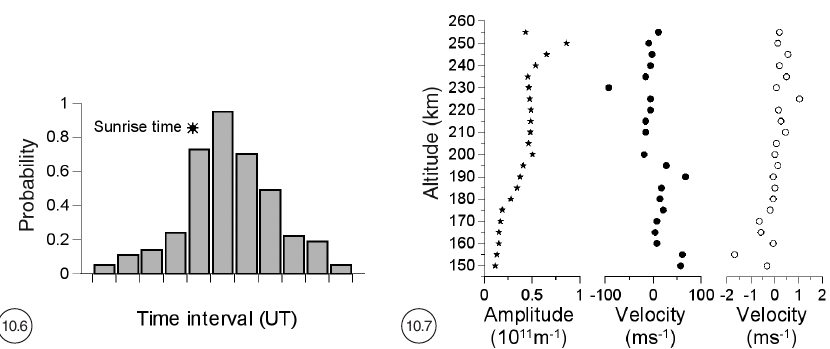
Fig. 10.6. Time variation of the probability of existence of a GWS event with dominant period of 61 min ob- served above Pr ° uhonice station (49.9°N, 14.5°E) during 31 October 1997 (adopted from Bos ˇ ka et al., 2003). Fig. 10.7. Altitude variation of the amplitude ( left ), phase velocity ( middle ) and group velocity ( right ) obtained for the wave event with dominant period of 72-min observed during October 12, 1996 in the Pr ° uhonice data (adopted from Bos ˇ ka et al., 2003).